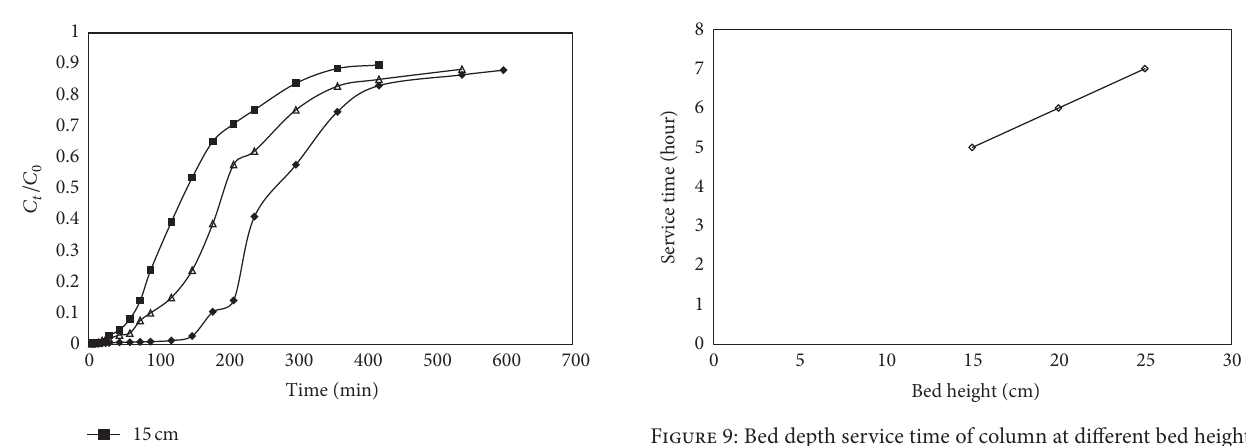
F 9: Bed depth service time of column at different bed height L and �ow rate = 25 F 7: Effect of bed height on breakthrough curve for Cr(VI) ion , �ow rate = 25mL/min). adsorption on EAM-CCRCBs ( 𝐶𝐶 0 = 300